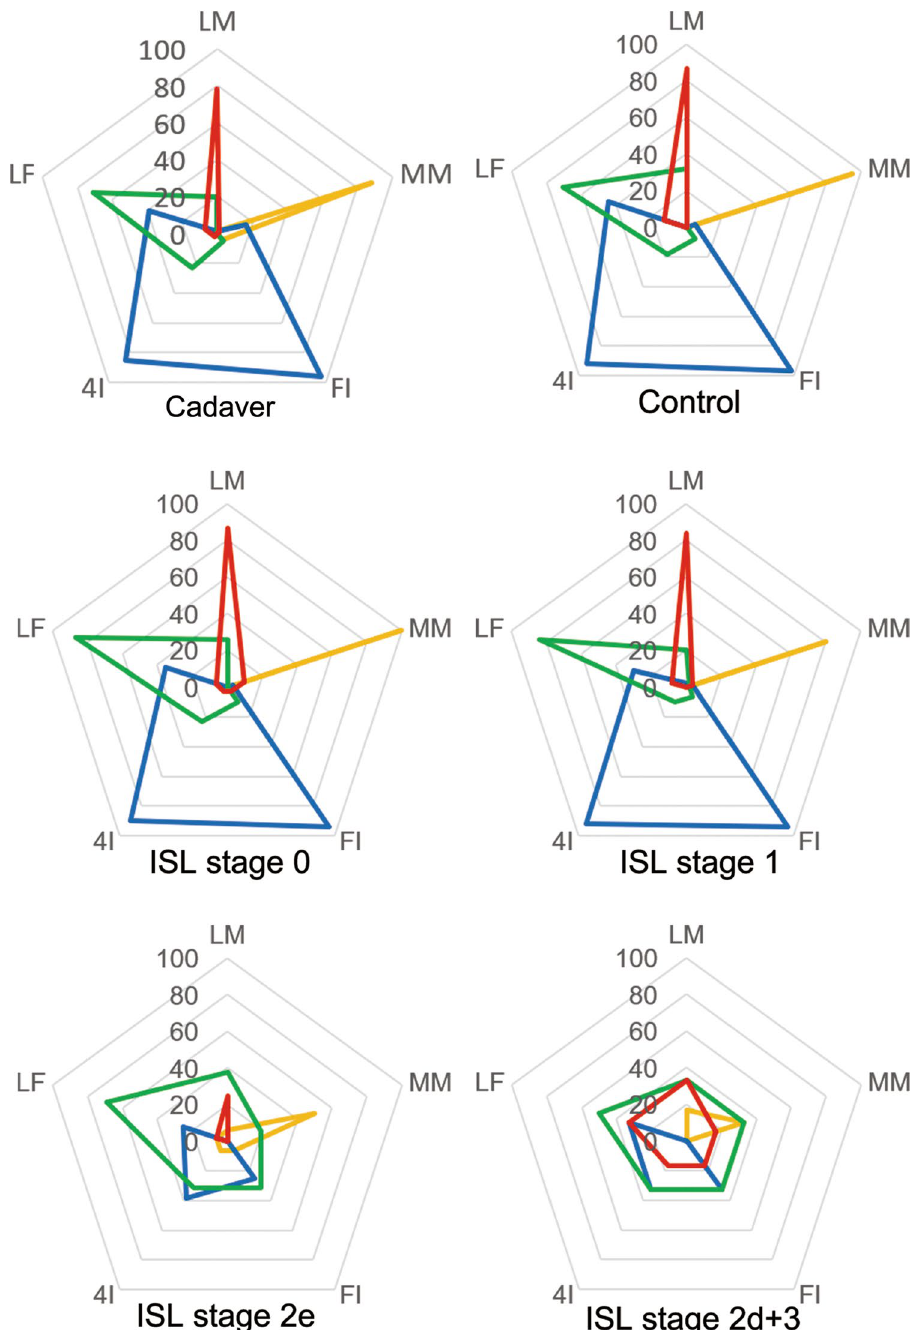
Figure 3. The relationship between injection sites and the lymphatic vessel groups: radar chart. The radar chart showed the percentage of visualization in the lymphatic pathways at each injection site. The number of axes shows the percentage of the visualization of each lymphatic pathway. The color of the radar line denote the four lymphatic pathways: anteromedial (blue), anterolateral (green), posteromedial (yellow), and posterolateral (red). In the controls, the rate of existence of the three lymphatic groups other than the anterolateral group exceeded 90%, and the use of four injection sites, other than the fourth interdigital space, made it possible to visualize the four lymphatic groups steadily. The mild lymphedema group (International Society of Lymphology [ISL] stage 0 + 1) had few defects in the lymphatic groups, and in ISL stage > 2, the defect rate in all lymphatic groups increased rapidly. The anterolateral group tended to be restricted to stage 3. MM medial malleolus, FI first interdigit space, 4I 4th interdigit space, LF lateral of foot, LM lateral